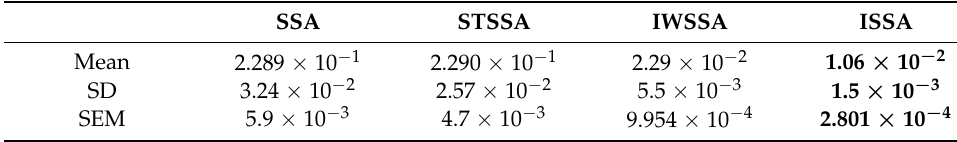
Table 3. Mean, SEM, and SD comparison.